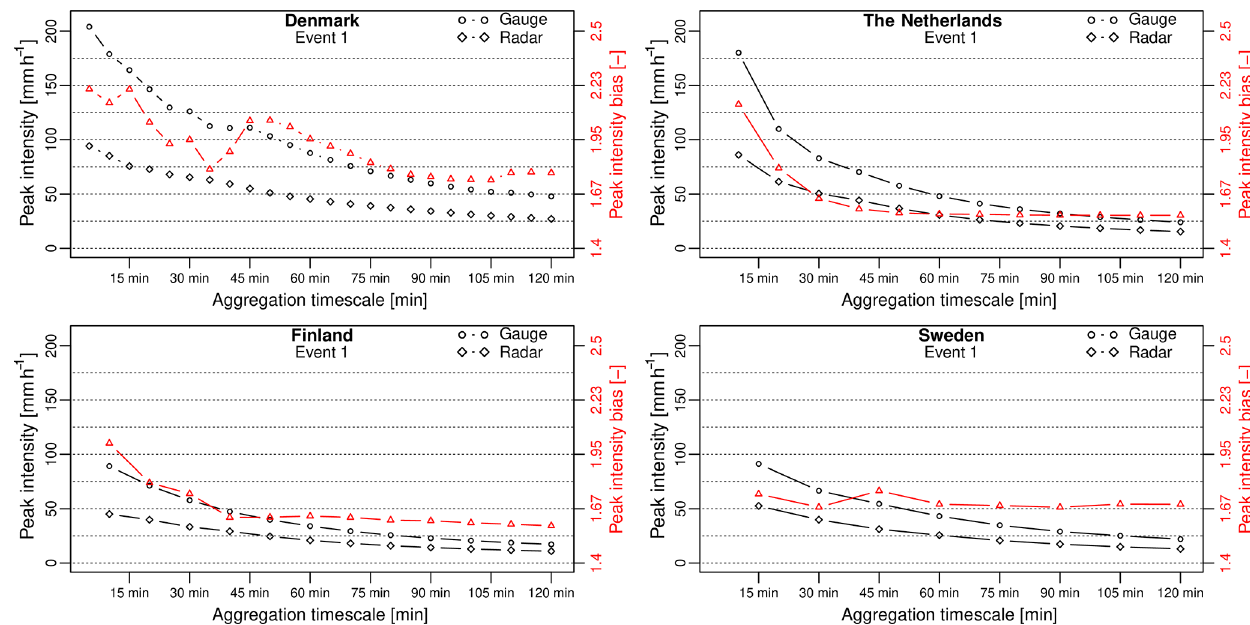
Figure 10. Peak rainfall intensities measured by radar and gauges as a function of the aggregation timescale for the top one event in each country. The red triangles show the peak intensity bias between radar and gauges (axis on the right).